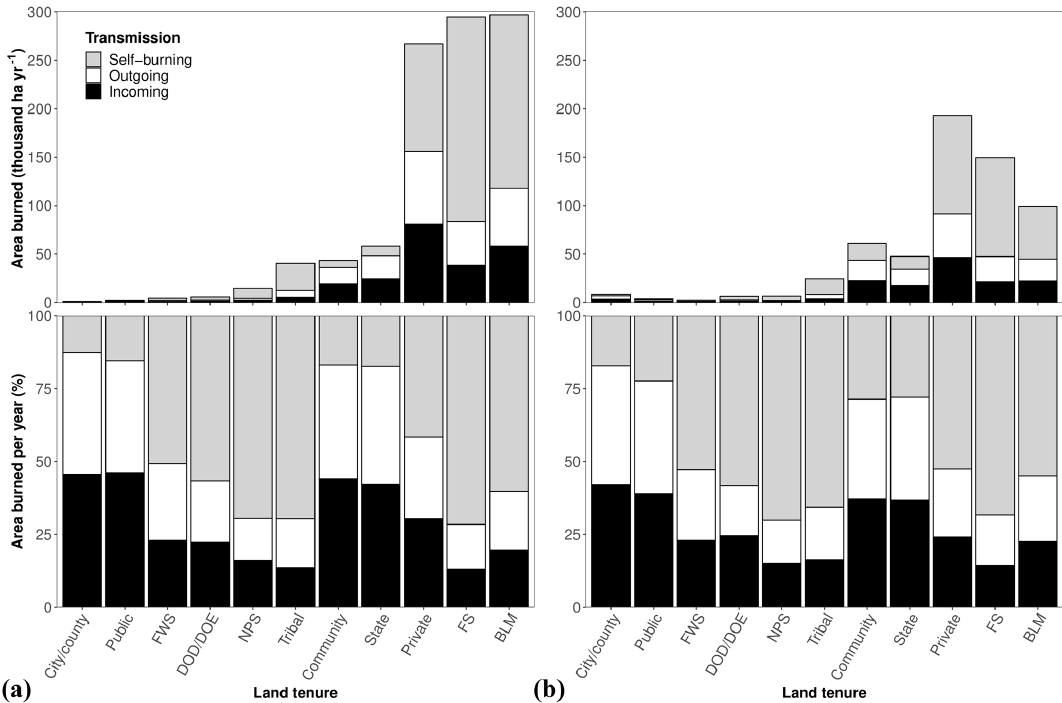
Figure 2. Fire exchange for the major land tenures of the 11 western US states estimated for (a) natural ignitions and (b) human ignitions. FS: Forest Service; BLM: Bureau of Land Management; NPS: National Park Service; FWS: Fish & Wildlife Service; DOD: Department